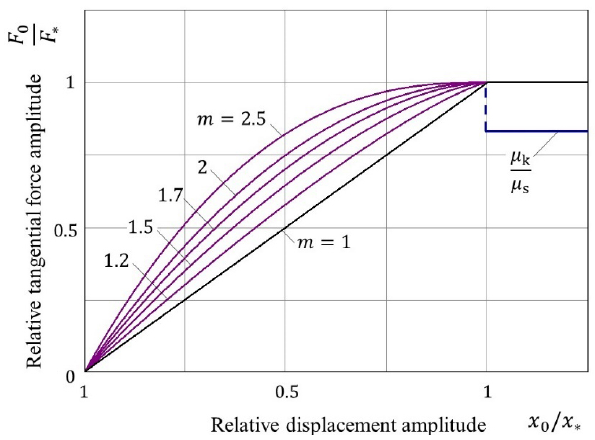
Fig. 7 Effect of the stiffness parameter m on the variation of the backbone curve for kinetic coefficients of friction ( backbone curve for